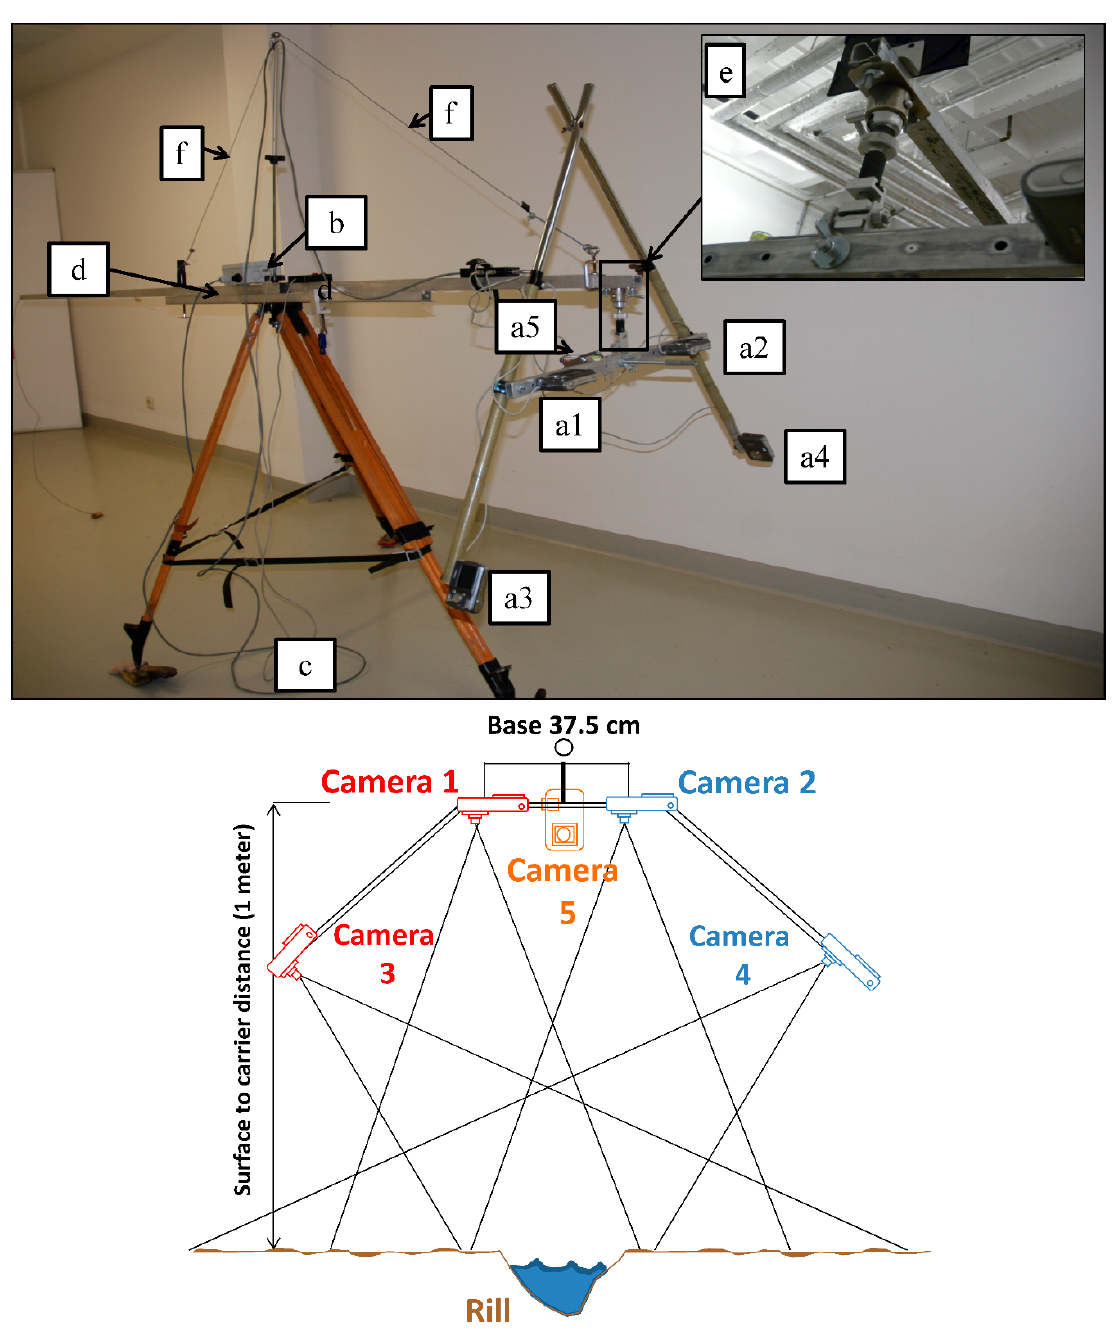
Figure3. TEPHOS(TerrestrialPhotogrammetricScanner). Fromimage( a1 )to( a5 ): cameras; ( b ): battery; Figure 3. TEPHOS (Terrestrial Photogrammetric Scanner). From image ( a1 ) to ( a5 ): cameras; ( b ): ( c ): tripod; ( d ): telescopic arm; ( e ): spherical joint; ( f ): guy battery; ( c ): tripod; ( d ): telescopic arm; ( e ): spherical joint; ( f ): guy wire.